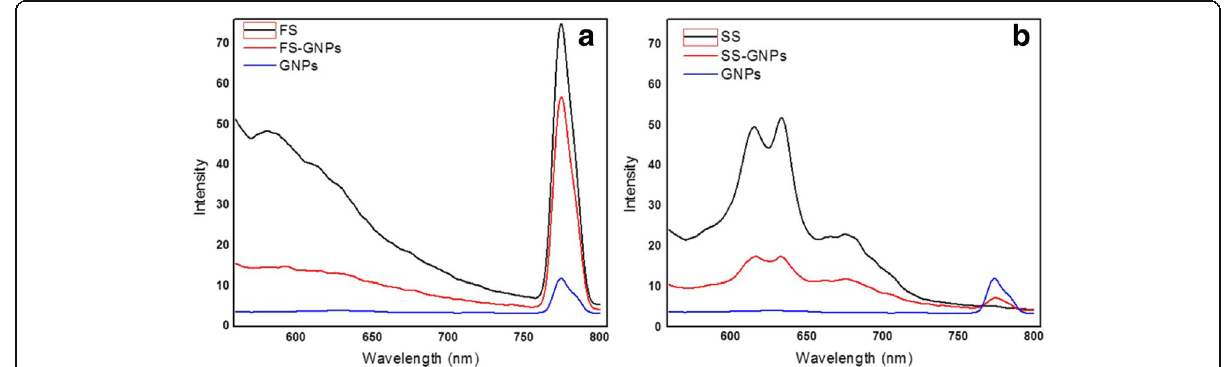
Fig. 7 Fluorescence spectra of a FS – GNPs and b SS – GNPs